Question: How would you classify this visualization?
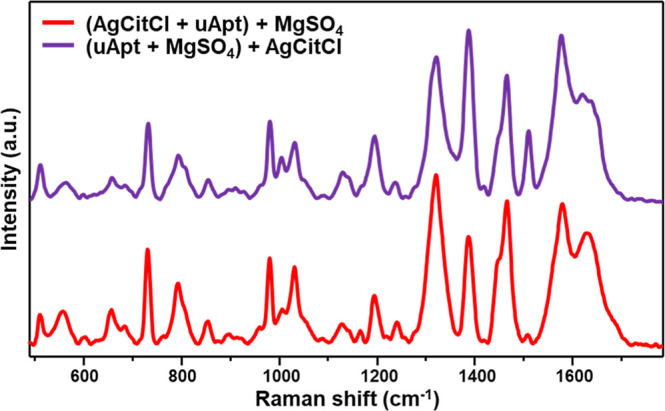
Answer: line